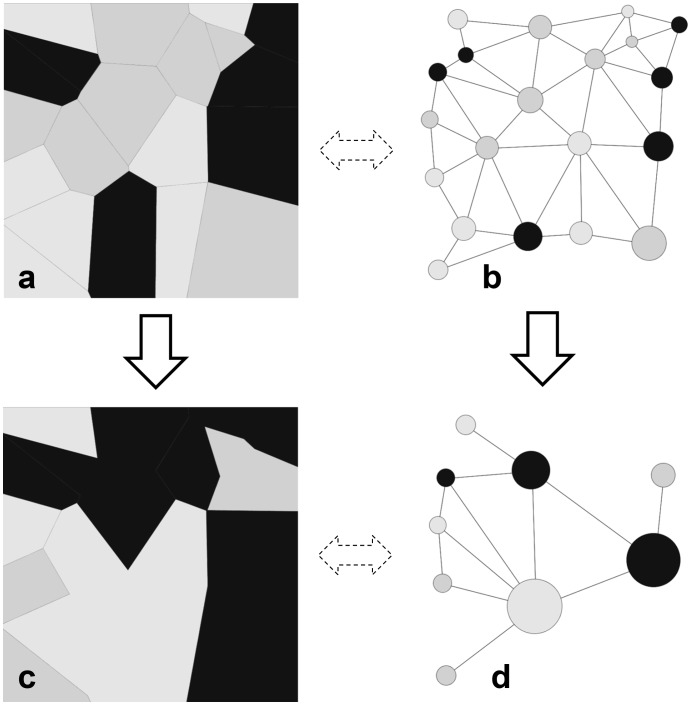
A patchy landscape sequence with its changing topology.A simple patchy landscape viewed by its patch mosaic (a) and its topological graph (b) at time step t, and at time step t+1 (c and d). The node properties displayed in the graph are the main patch attribute (the land cover, in gray scale), and the patch surface (the disc size). Vertical arrows represent time changes of the landscape (1a, 1c) and dashed horizontal arrows represent the link between geometrical mosaics and topological graphs (1b, 1d). Here, merges and random (land cover) rotations, both with a probability p = 0.5, have been applied between the two time steps.